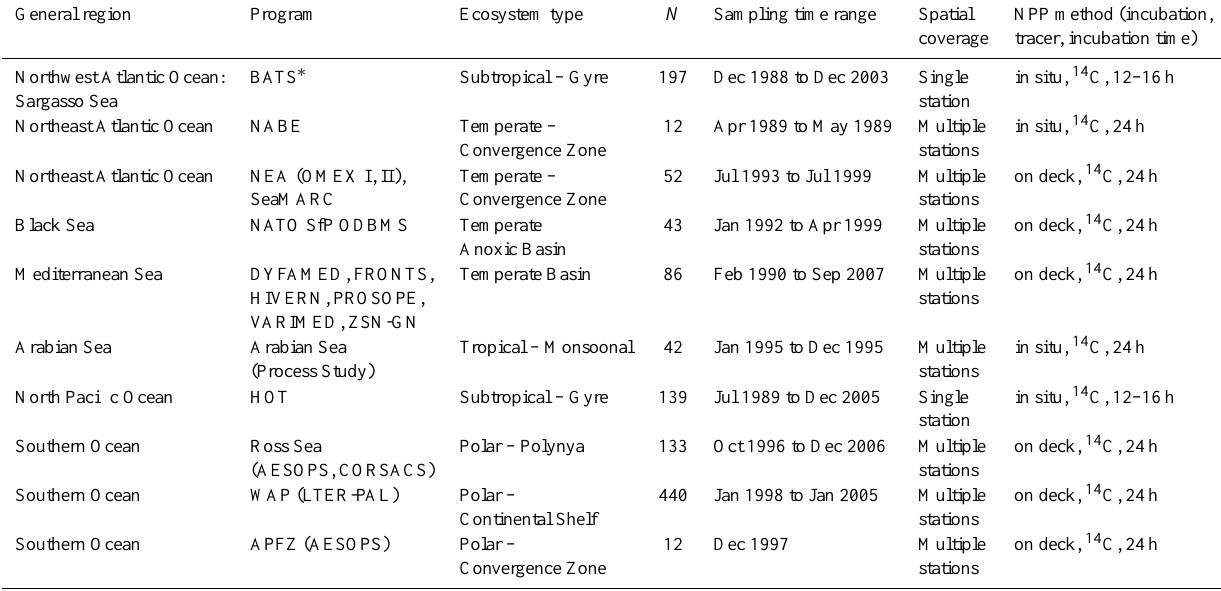
∗ Program descriptions are listed in Table S1 of the Supplement.